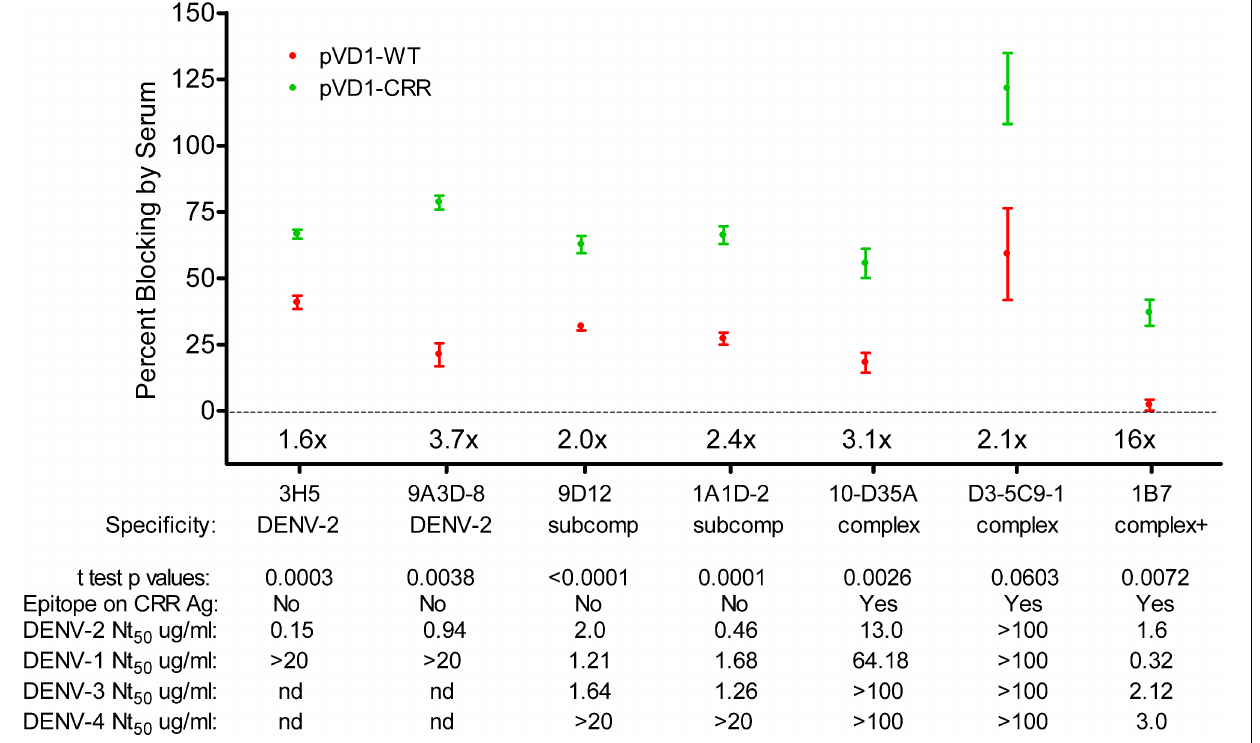
complex, DENV complex cross-reactive and complex + supercomplex cross-reactive). Below specificity, p -values from a two-tailed t test comparing percent blocking for each vaccinated sera are depicted. Below that the presence or absence of the epitope recognized by each MAb on the DENV-1 CRRVLP antigen is depicted (all MAbs recognize epitopes found in the DENV-2 challenge virus). For example, 3H5 and 9A3D-8 as DENV-2 specific antibodies are absent on both pVD1-WT and pVD1-CRRVLP antigens; 9D12 and 1A1D-2 reactivity are ablated by the EDIII CR substitutions in the pVD1-CRR plasmid ( Table 2 ) but present in theWT DENV-1 antigen; and 10-D35A, D3-5C9-1, and 1B7 reactivities were not altered by the substitutions introduced into in the pVD1-CRR plasmid and hence are present on both DENV-1WT and CRR immunization antigens. FR μ NT 50 titers for each